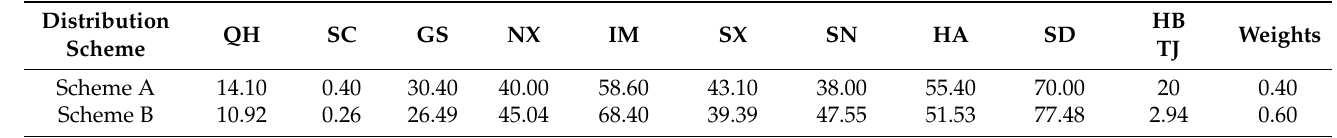
Table 2. Calculation results of water distribution and weights of the two water distribution schemes. (100 million m 3 ).